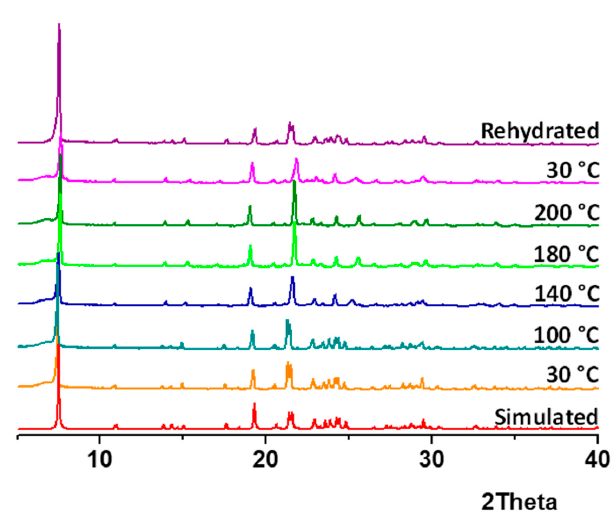
Figure 3. X-ray diffraction patterns of Solid 1 at different temperatures and after rehydration.